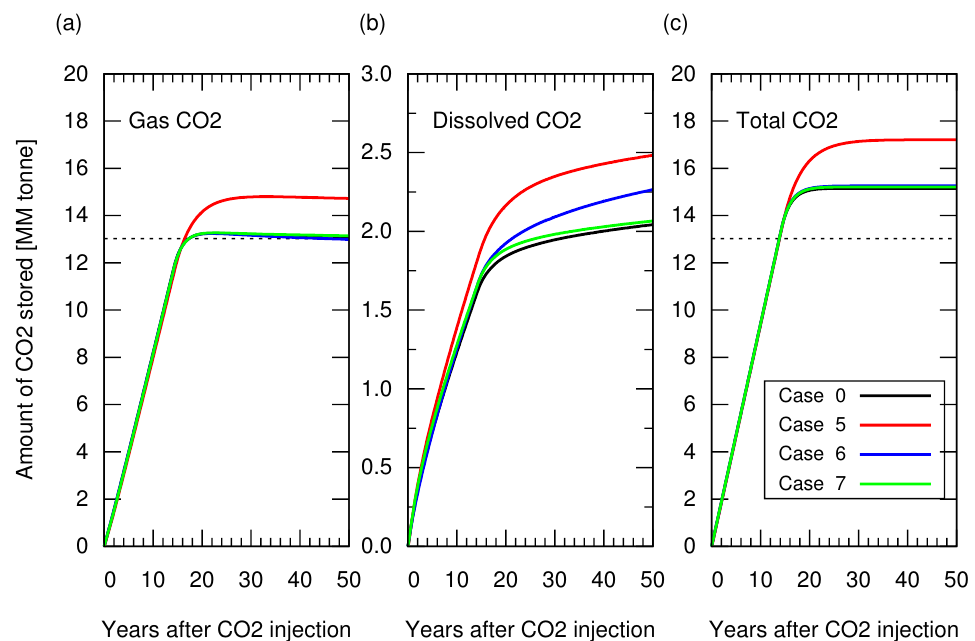
Figure 8. Amount of CO 2 stored in the reservoir for cases 0 and 5 to 7 as a function of years after CO 2 injection. ( a ) Structurally trapped CO 2 as a gas (super-critical) phase. All lines, except for case 5 in red, overlapped each other, meaning a similar profile among these cases; ( b ) CO 2 trapped as a dissolved component in water; ( c ) Total amount of trapped CO 2 (i.e., sum of structurally trapped CO 2 and dissolved CO 2 ). The dotted lines in ( a , c ) indicate the CO 2 storage amount estimated from Equation